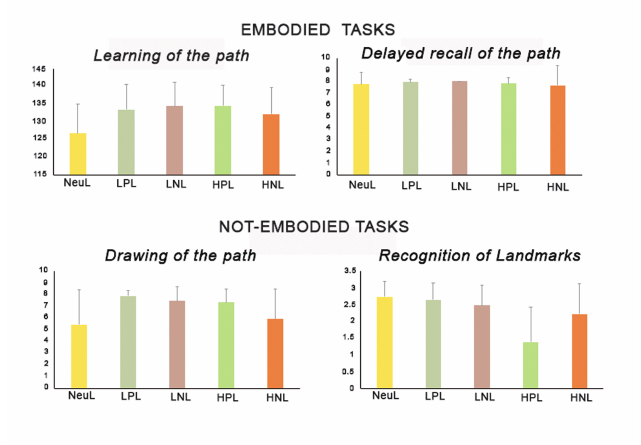
Figure 2. Mean performances and SD of participants in embodied and not-embodied